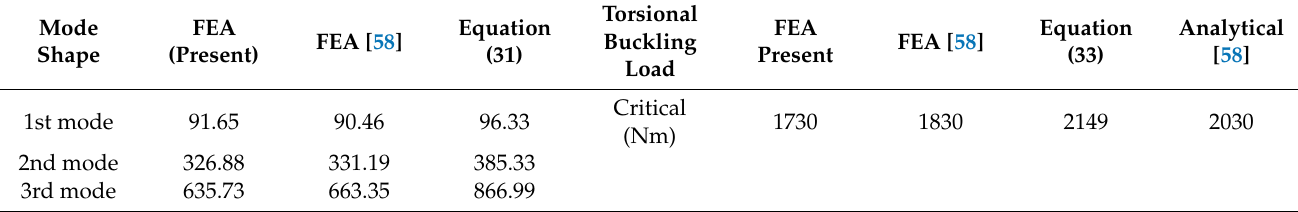
Table 3. Comparison in the first three natural frequencies and critical torsional buckling